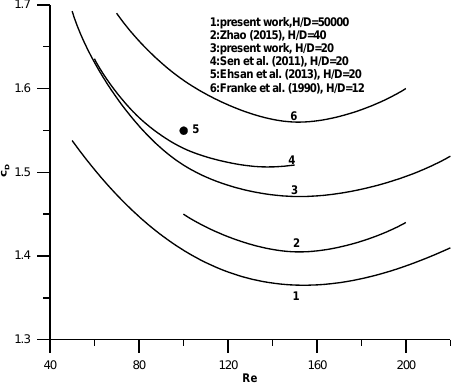
Figure 3. Variation of drag coefficient across a square cylinder for a Newtonian fluid as a function of Reynolds number at different non-dimensional heights of computational domain.